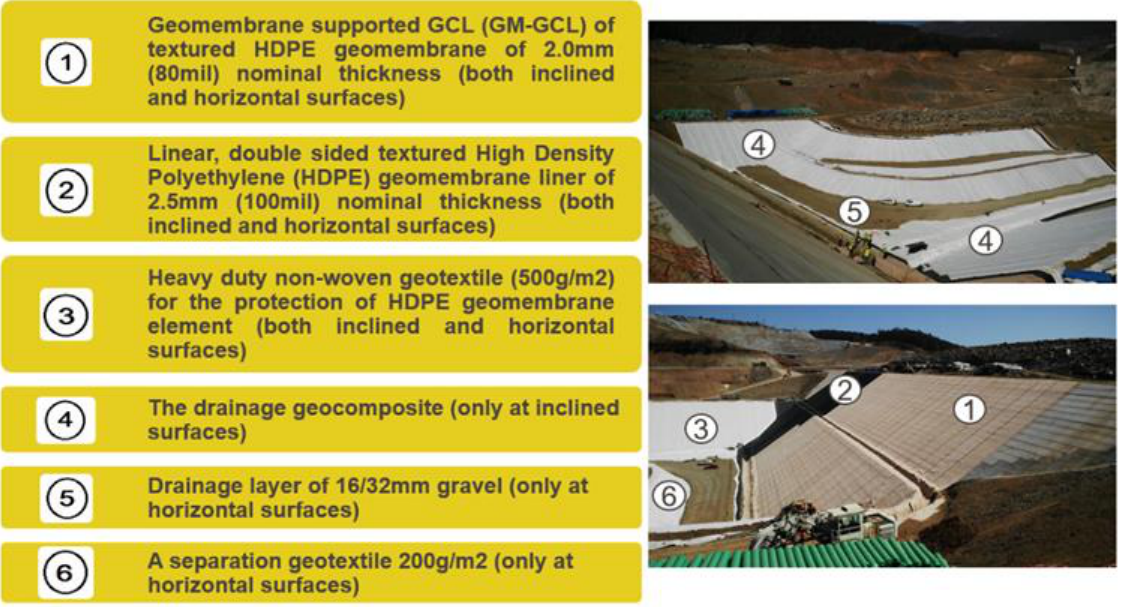
Figure 6. Upstream embankment engineering.